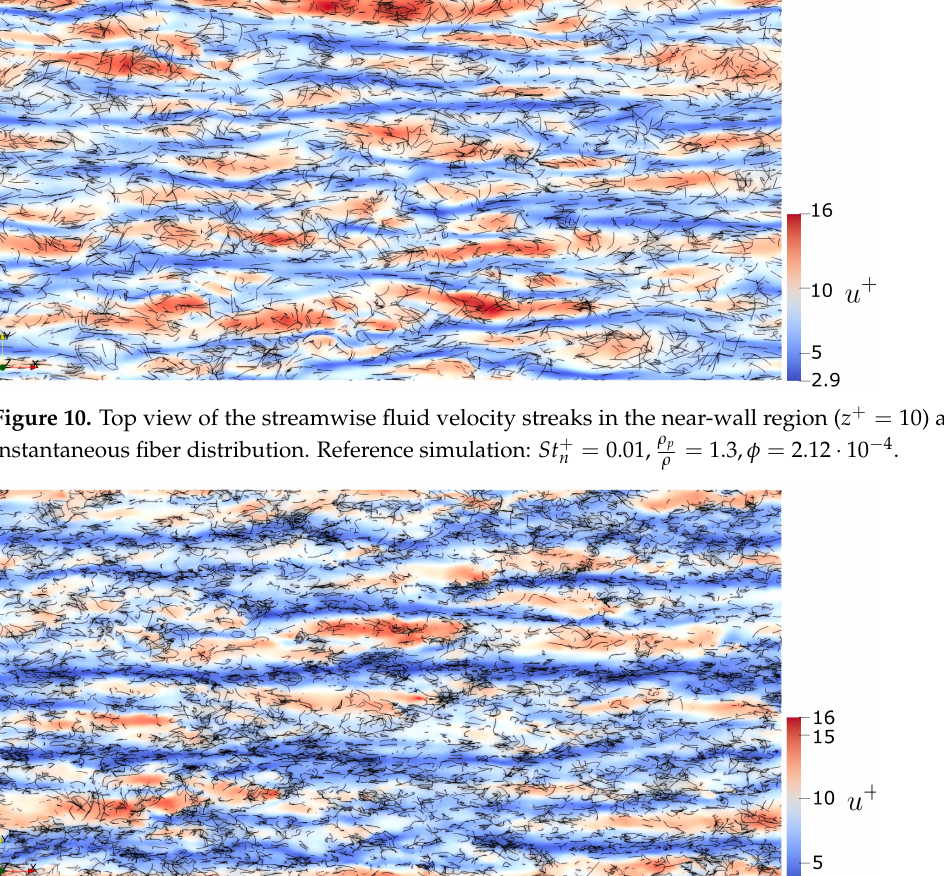
Figure 11. Top view of the streamwise fluid velocity streaks in the near-wall region ( z + = 10) and instantaneous fiber distribution. Reference simulation: St + n = 10, ρ p